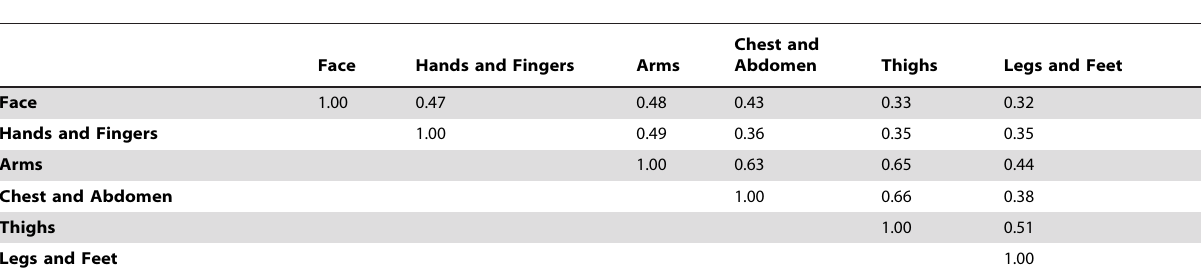
Table 2. Pearson Correlations between Body Area-Specific Scores 1